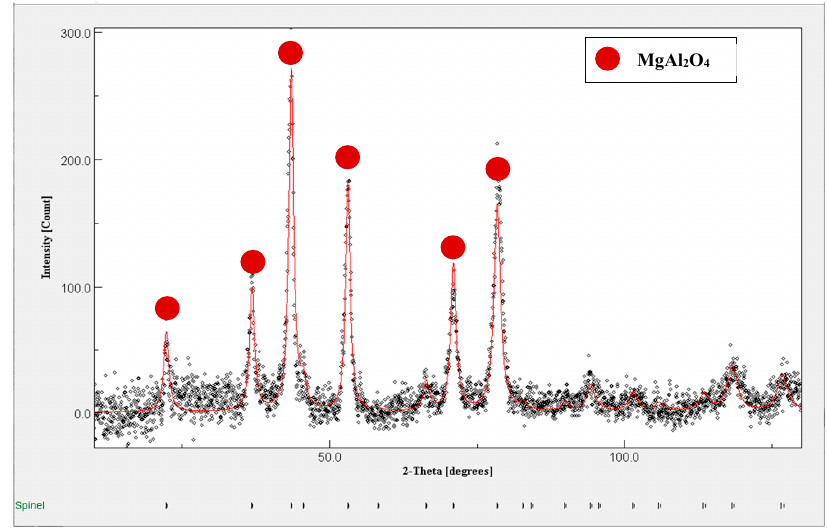
Figure 3. XRD patterns of the PP waste. From the data, the PP waste is observed to contain only one phase: spinel. Figure 4 provides the details on the morphology of two different categories of PP waste particles. In Figure 4a,b, both particles are quite flat and have flakes attached onto their surfaces. An average analysis of the point EDXS analysis conducted on different sites of different PP waste particles are presented in Table 4. Irrespective of the flakes or the flat region, the particles predominantly contain Al, O and Mg, confirming that they are mainly constituted by Mg aluminate. Traces of Fe and Mn are also present (as compared to Table 1).